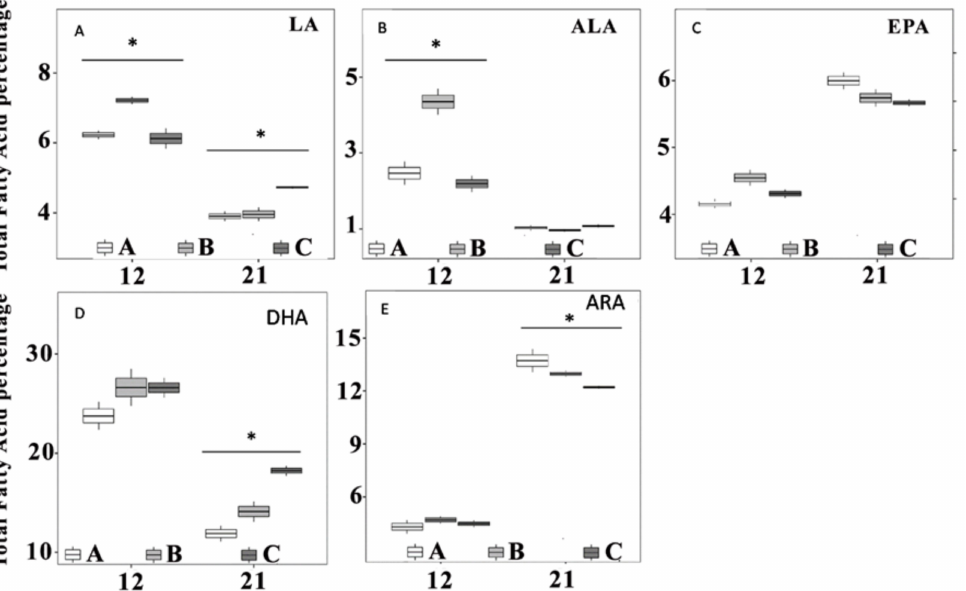
Figure 3. Larval Essential Fatty acids composition from the three treatments A ( Nannochloropsis ), B ( Chlorella ) and C (Spresso), after 12- and 21-days post hatch. ( A ) linoleic acid (LA), ( B ) alpha linoleic acid (ALA), ( C ) eicosapentonoic acid (EPA), ( D ) doxosahexaenoic acid (DHA), ( E ) arachidonic acid (ARA). Three samples 0.05 g of larvae per treatment were analyzed. Dots shown are the outer layers, whiskers indicate the maximum and minimum values excluding out layers, the line in the middle of box is the median value, and upper and lower quartiles are the ends of the box. Statistically significant di ff erences between treatments are marked with an